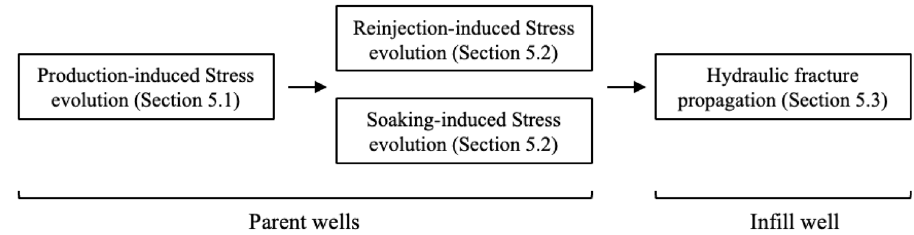
Fig. 3 The flowchart of this